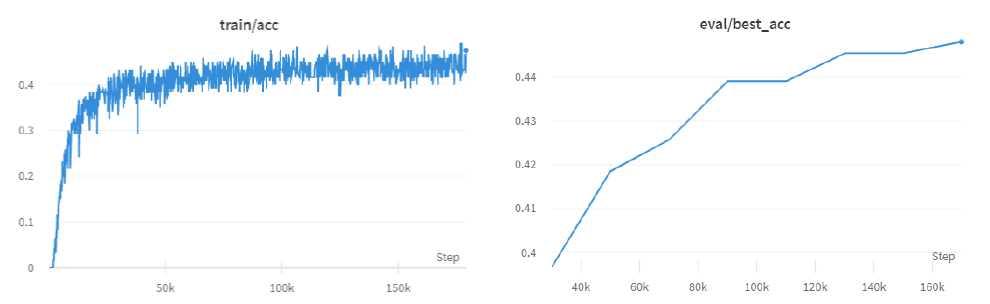
Figure 10. Best training and evaluation accuracy in ‘Experiment 6’.